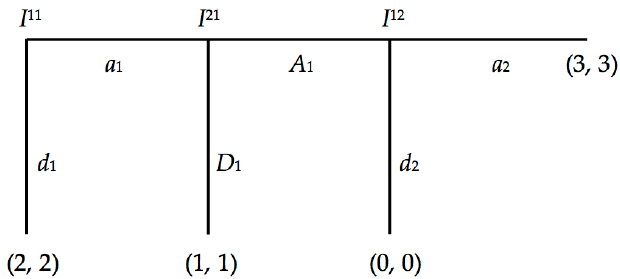
Figure 1. I ij is the j ‐ th information set ( j ≥ 1) of agent i ( i = 1, 2). Robert Stalnaker’s game has two pure strategies at each information set: Either ‘Down’ ending the game, or ‘Across’ allowing the other agent to choose an action. The agents’ payoffs are represented at the tree’s endpoints, the left member being the first agent’s payoff, the right member being the second agent’s payoff. The backward induction profile is ( a 1 a 2 , A 1 ).